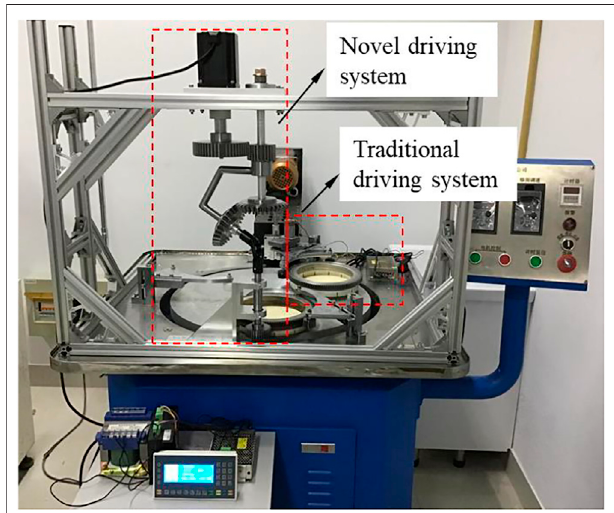
FIGURE 6 | Experimental setup.